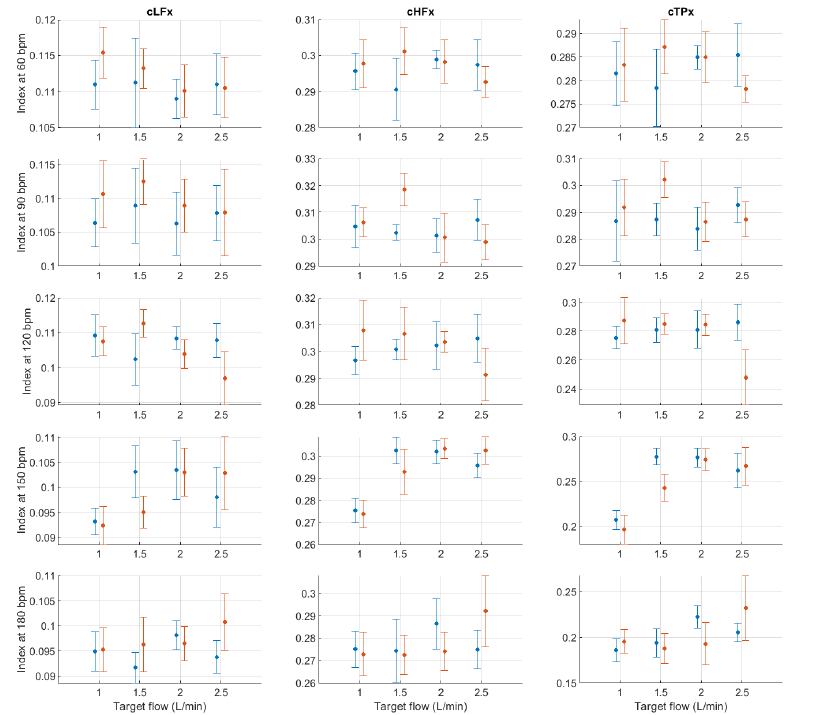
Figure A10. Mean and standard deviation of the x -coordinates of the centroid-related indices extracted from pulse rate variability under different stroke rates (SR) and target flows (TF, TF below 2.5 L/min) conditions, and measured from the radial (blue) and deep palmar arch (orange)